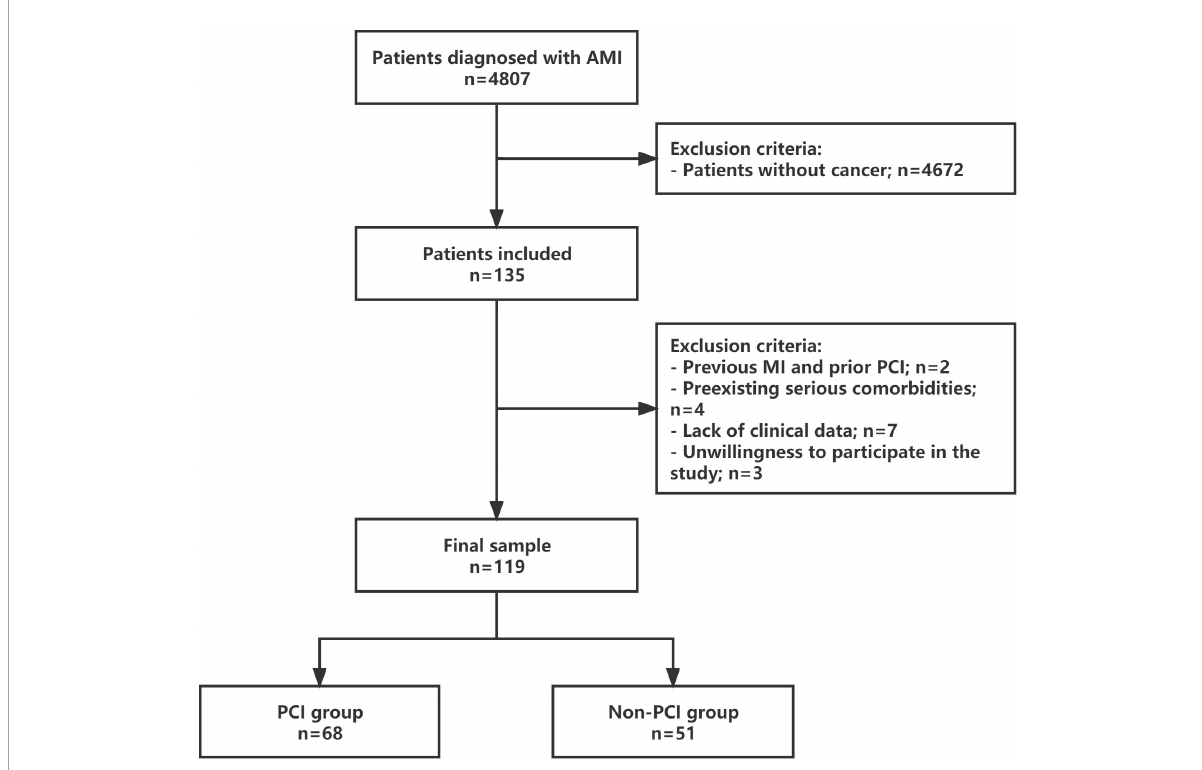
FIGURE1 Study protocol. Flowchart of the selection process and dropouts of the current study. AMI, acute myocardial infarction; MI, myocardial infarction; PCI, percutaneous coronary